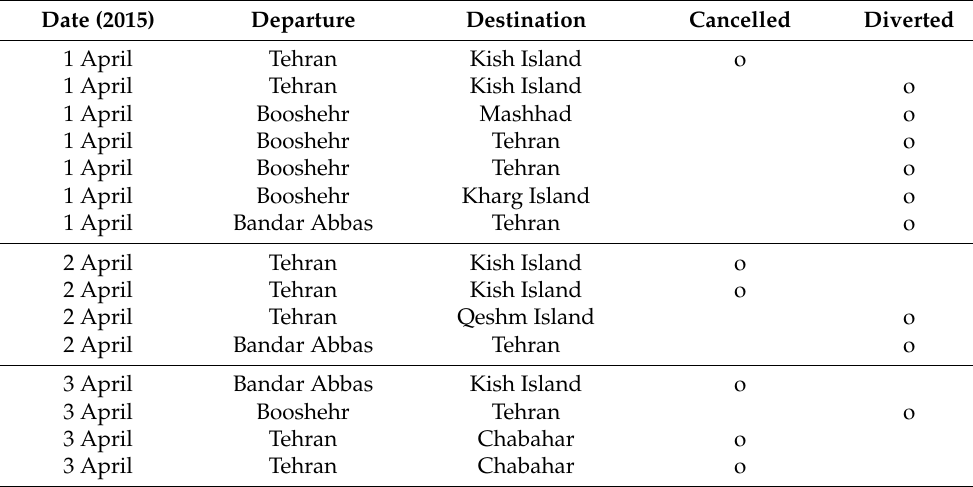
Table 4. Domestic flights in Iran affected by the April 2015 dust storm